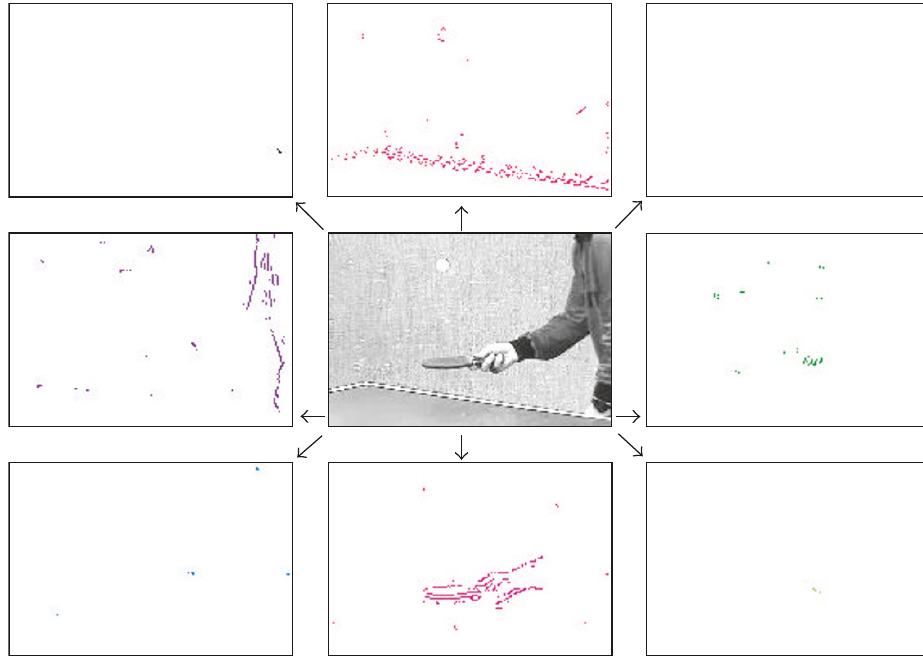
Figure 4: Points in motion at time t = 4 for video sequence in Figure